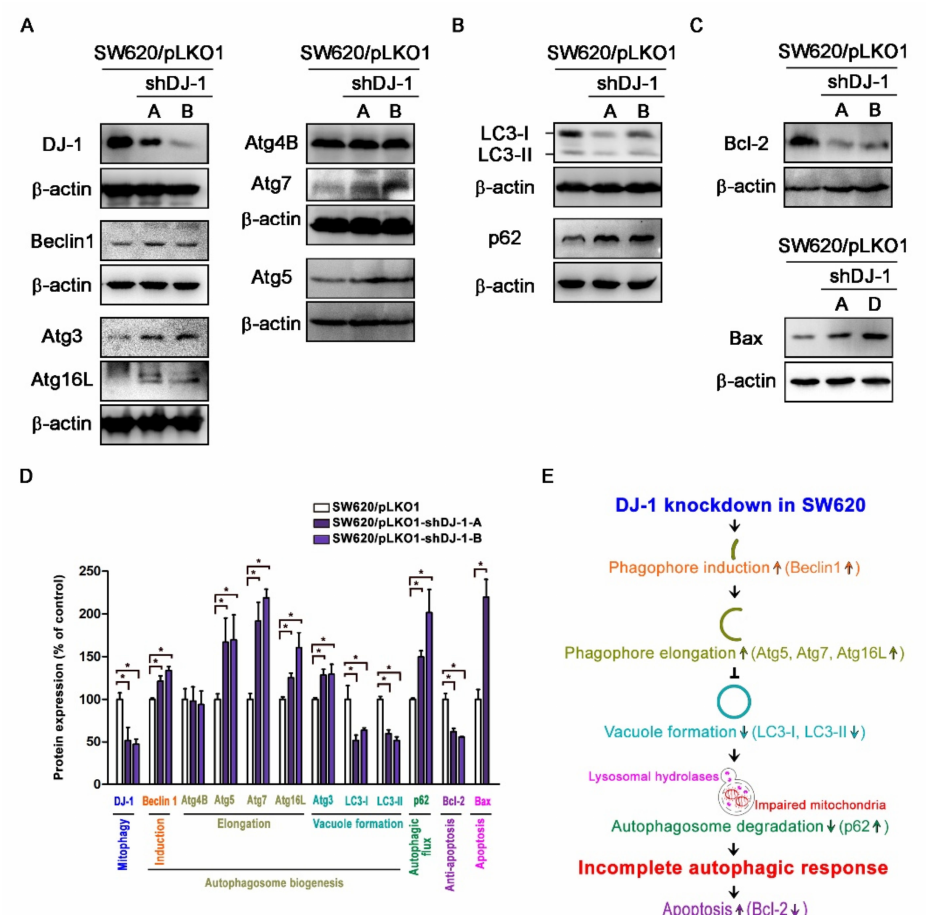
Figure 5. DJ-1 knockdown induces an incomplete autophagic response and cell apoptosis in metastatic colorectal adenocarcinoma cells SW620. ( A ) Western blot results show that pLKO-1- shDJ-1 plasmids effectively inhibited DJ-1 expressions in SW620/pLKO1-shDJ-1-A and -B cell clones compared with the control cell clone (SW620/pLKO1). Beclin 1, Atg3, Atg5, Atg7, and Atg16L increased in DJ-1 knockdown cell clones (SW620/pLKO1-shDJ-1-A and -B) compared with control (SW620/pLKO1). It indicates that DJ-1 knockdown enhances phagophore induction (Beclin1 in- creased) and elongation (Atg5, Atg7, and Atg16L increased) during autophagosome biogenesis in metastatic colorectal adenocarcinoma cells. ( B ) Western blot results show LC3 decreased and p62 increased in DJ-1 stable knockdown cell clones (SW620/pLKO1-shDJ-1-A and -B) compared with con- trol (SW620/pLKO1), indicating that DJ-1 knockdown inhibits vacuole formation (LC3-I and LC3-II decreased) and autophagosome degradation (p62 increased) in metastatic colorectal adenocarcinoma cells during autophagosome biogenesis. ( C ) Western blot results show that Bcl-2 decreased and Bax increased in DJ-1 knockdown cell clones (SW620/pLKO1-shDJ-1-A, -B, or -D) compared with control (SW620/pLKO1). Our data suggest that DJ-1 knockdown induced an incomplete autophagy response and cell apoptosis. ( D ) The quantification data of each protein level with its function are shown here. Data are expressed as the means ± S.E.M; the Student’s t -test determined the p -value. *: p < 0.05 compared with control (SW620/pLKO1). ( E ) A proposed model shows that DJ-1 knockdown induces incomplete